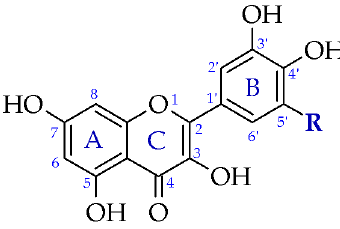
Table 1. The characteristic parameters of complexes of sulfonated flavonoids with metal cations. Refcodes for the crystal structure analyses were taken from the Cambridge Structural